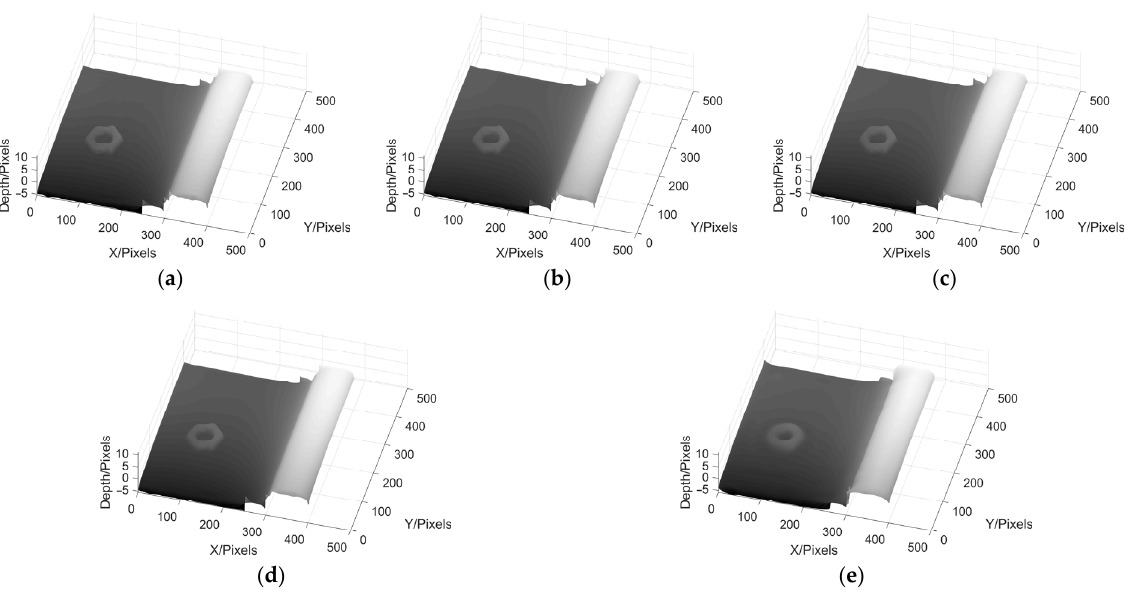
Figure 19. Phase reconstruction results of wheel tread with a nut using different filters. ( a ) MP based on Ideal low-pass; ( b ) MP based on Hanning; ( c ) MP based on Blackman; ( d ) MP based on Kaiser; ( e ) MP based on Hilbert transform.